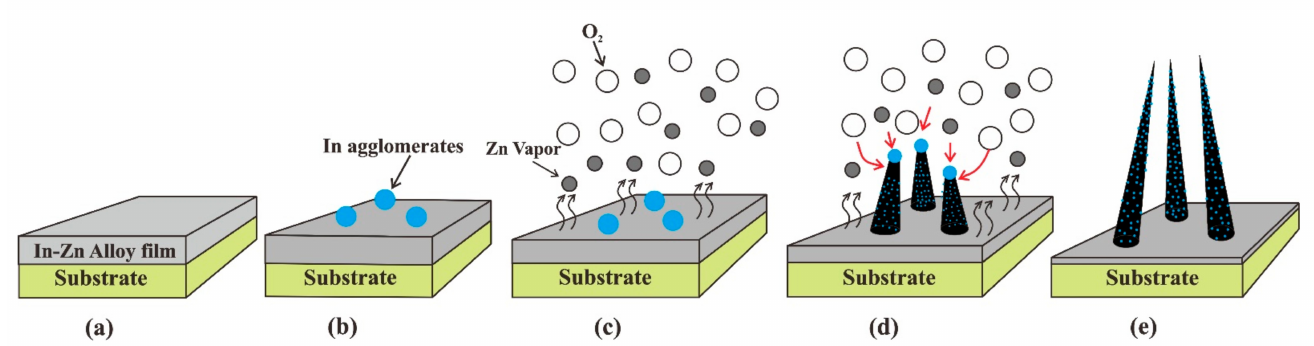
Figure 5. Schematic diagram of the growth process of In-doped ZnO nanowires. ( a ) The In-Zn alloy film was deposited on the substrate, ( b ) indium agglomerates precipitated on the film surface, ( c ) zinc vaporized from the film, ( d ) ZnO nanowires grew from the In catalyst, ( e ) the In-doped ZnO nanowire after